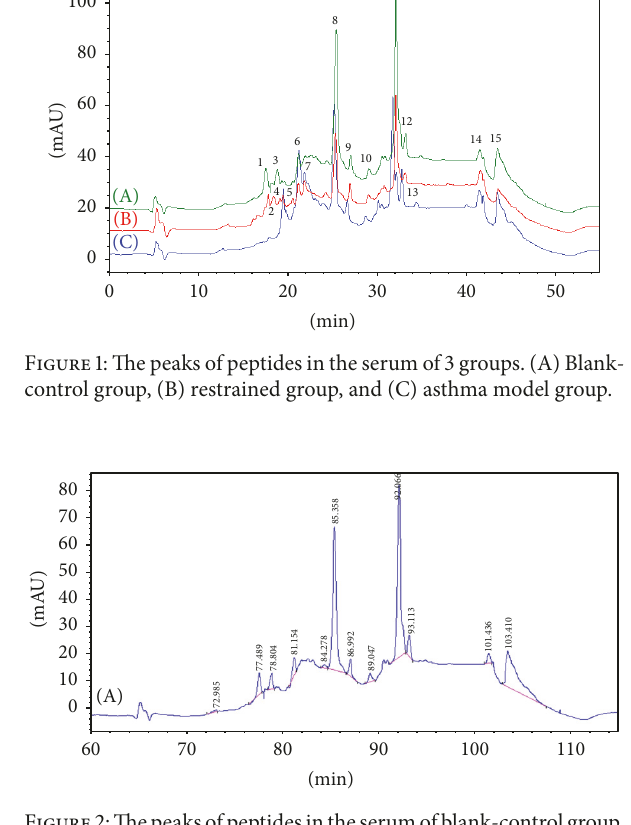
Figure2:Thepeaksofpeptidesintheserumofblank-controlgroup.